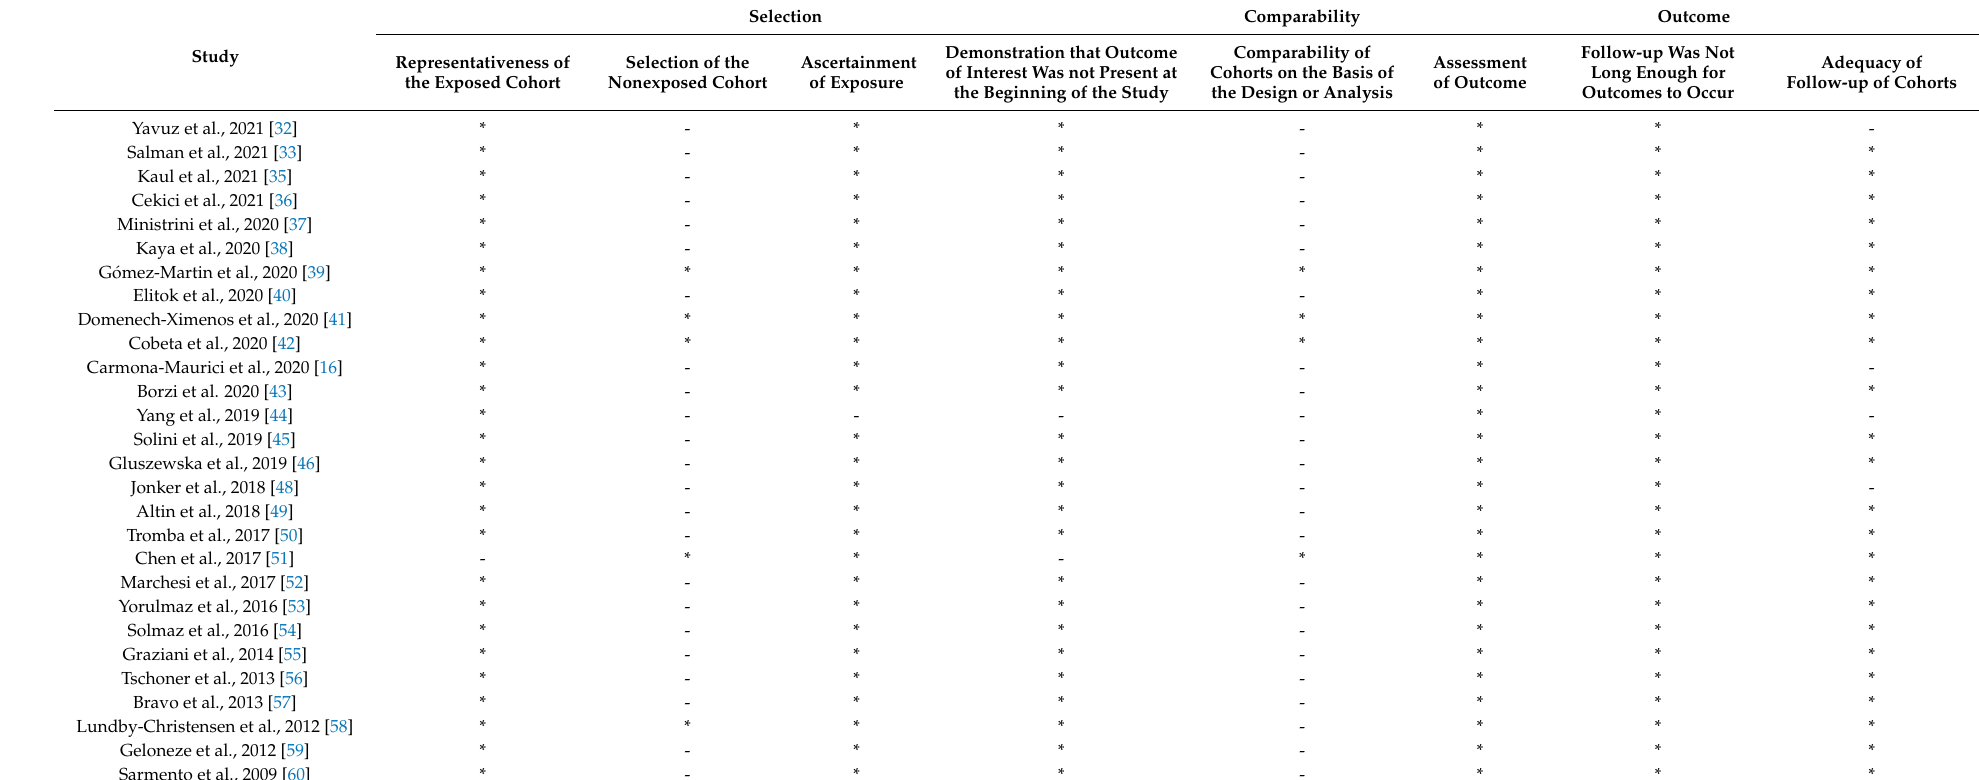
Table 2. Quality of bias assessment of the included publication in accordance with the Newcastle–Ottawa scale (cohort studies).